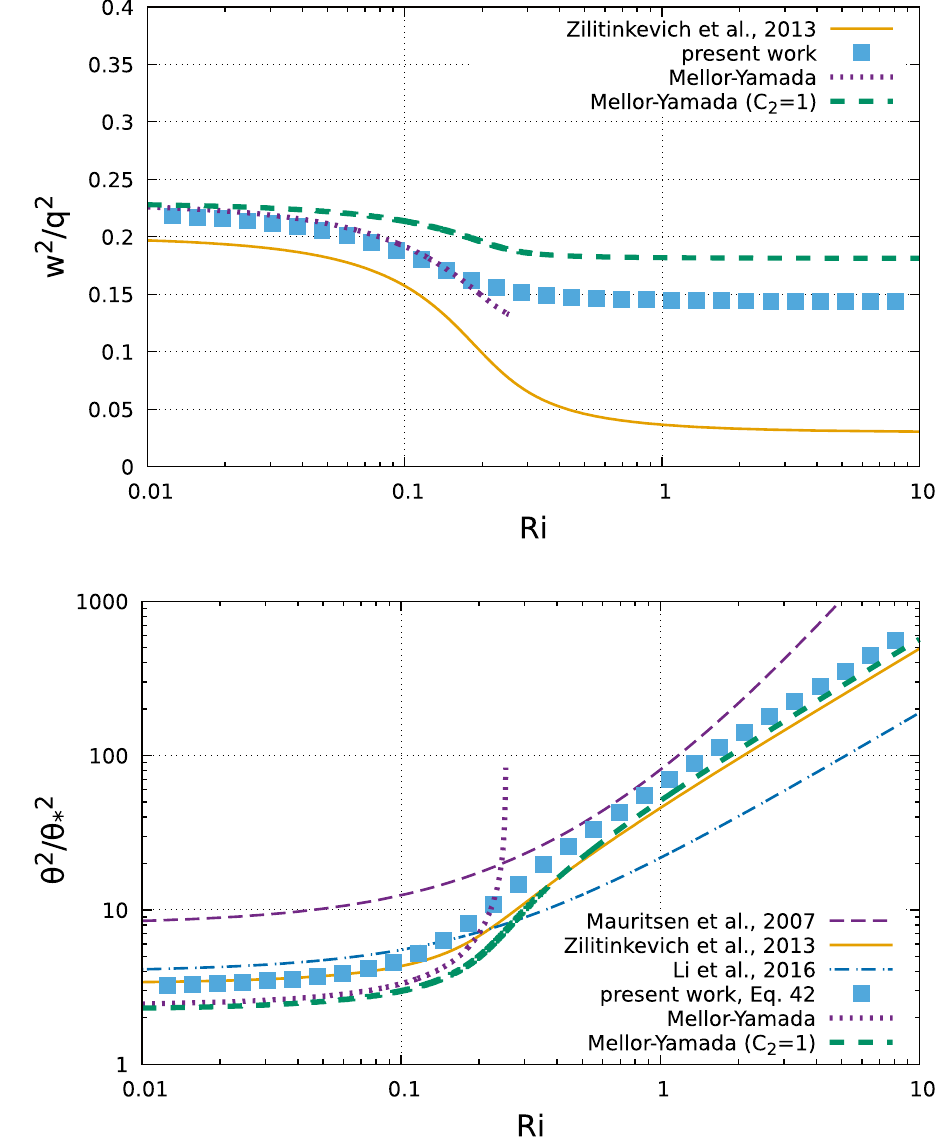
Fig. 6 Blue squares: tem- perature variance from Eq. (42) as function of Ri . Coloured lines: expression from